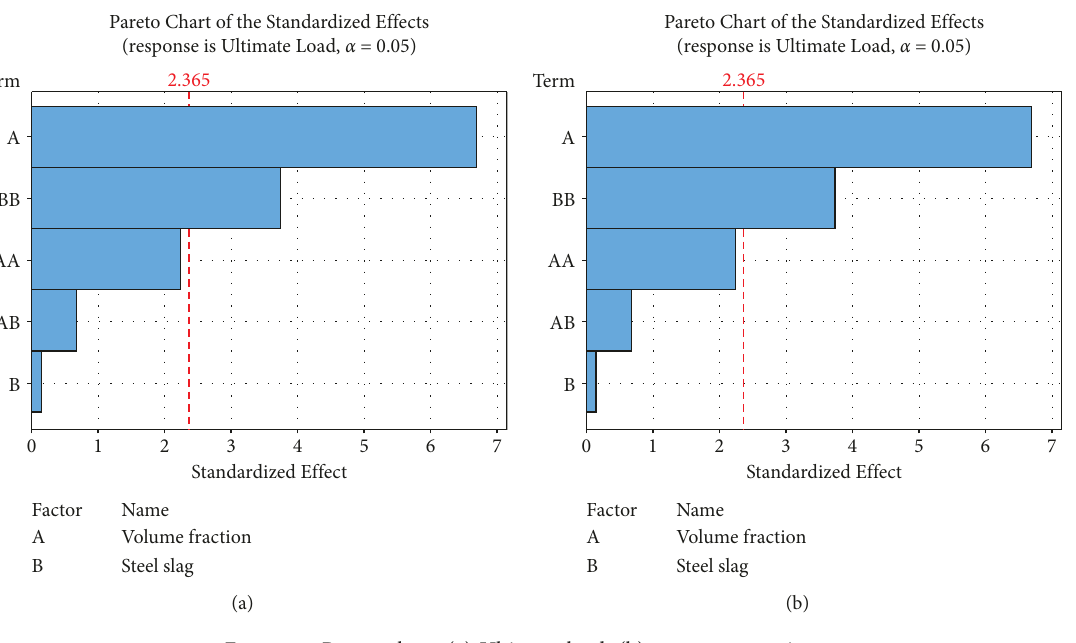
Figure 7: Pareto chart. (a) Ultimate load; (b) moment capacity. Surface Plot of UL_of_FC